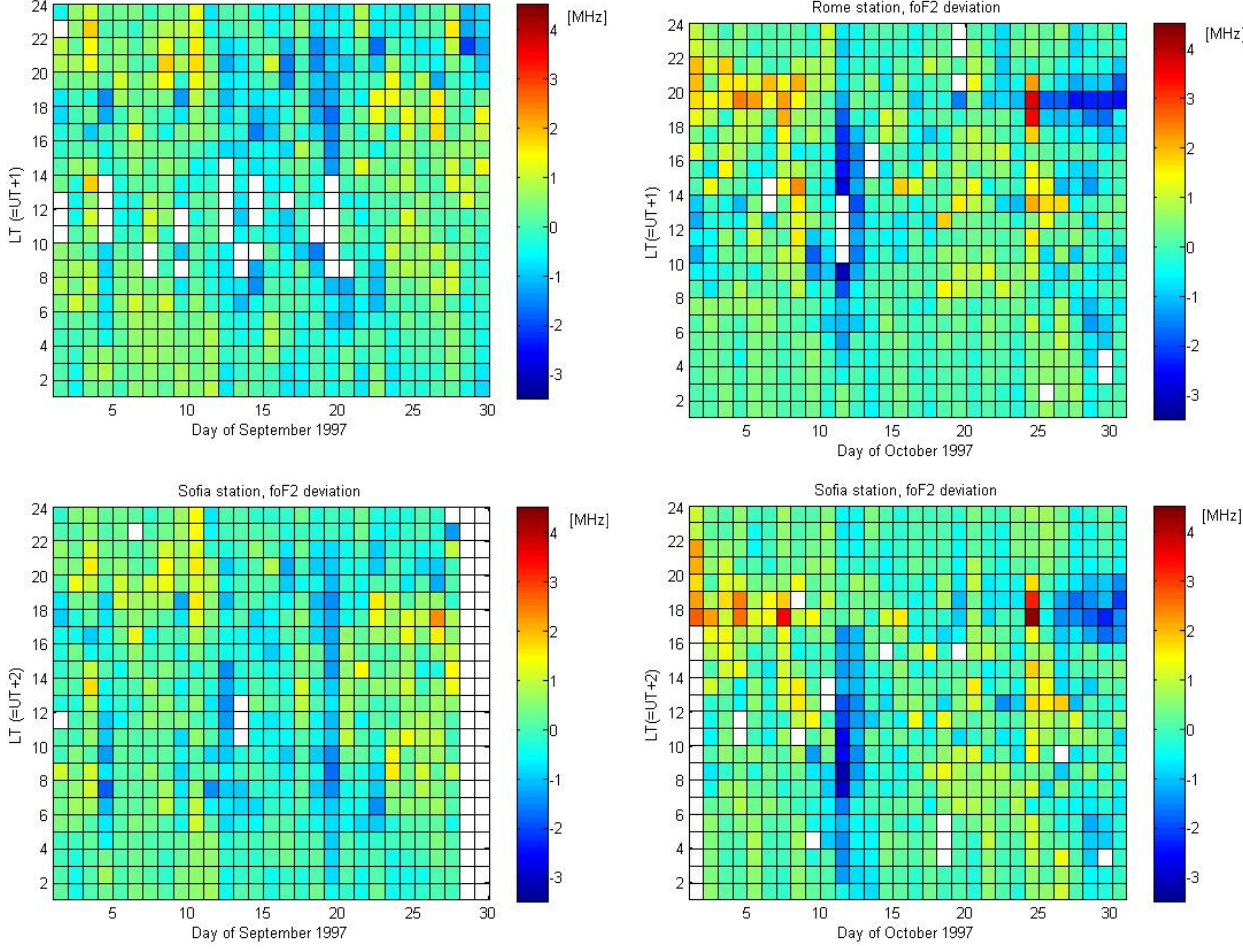
Fig. 7a September (a) and October 1997 (b) are depicted. Horizontal axis denotes days of month, vertical axis – local time (LT). The foF2 deviations are colored depending on the sign and magnitude for every day and LT. The white boxes spread indicate an absence of data for the foF2